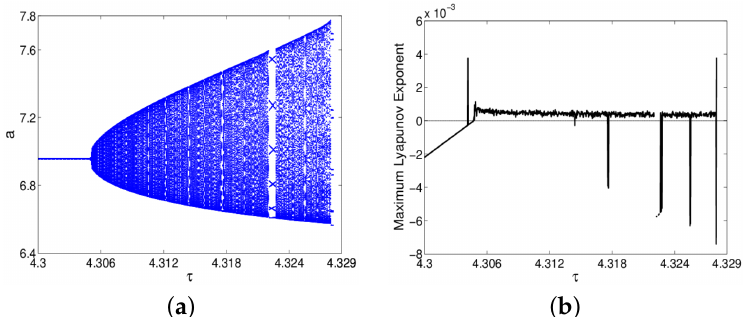
Figure 2. ( a ) Neimark-Sacker bifurcation diagram; ( b ) Maximum Lyapunov exponents.